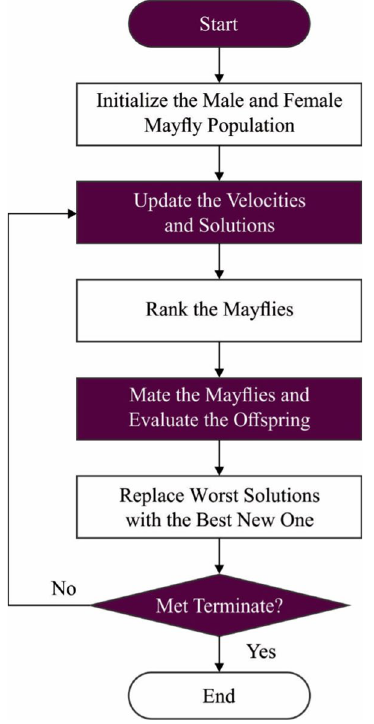
Fig. 4 Flowchart of